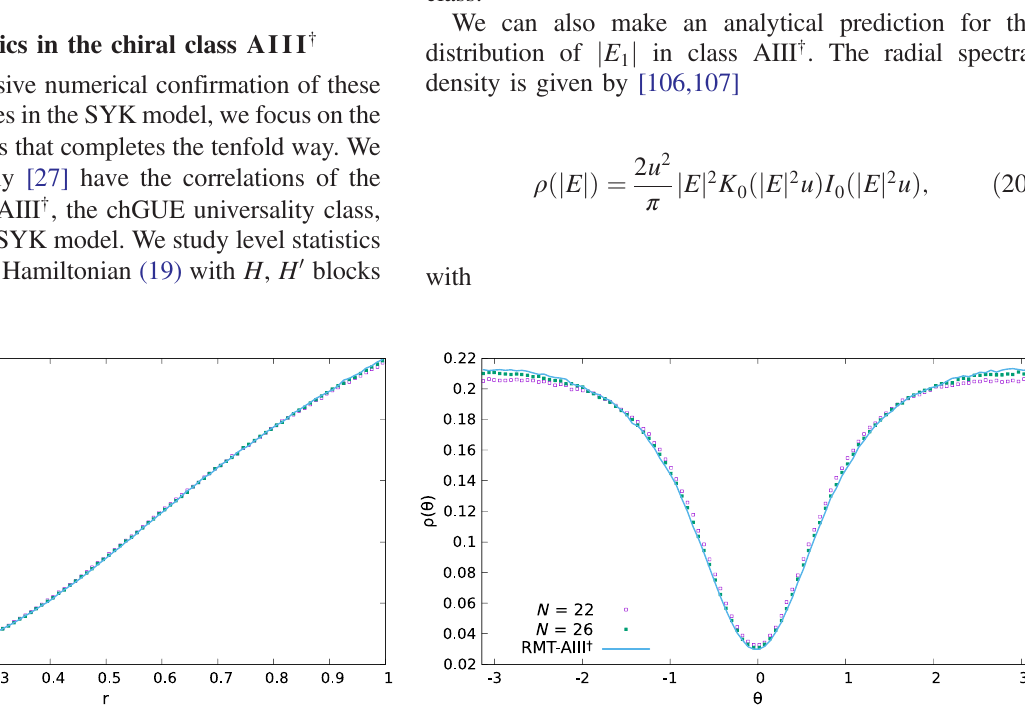
FIG. 12. Radial (left panel) and angular (right panel) density of the complex spacing ratio defined by Eq. (17) for the nHWSYK Hamiltonian Eq. (19) with N ¼ 22 , 26 and about 20 000 disorder realizations. We see agreement with the predictions of the AIII † in all